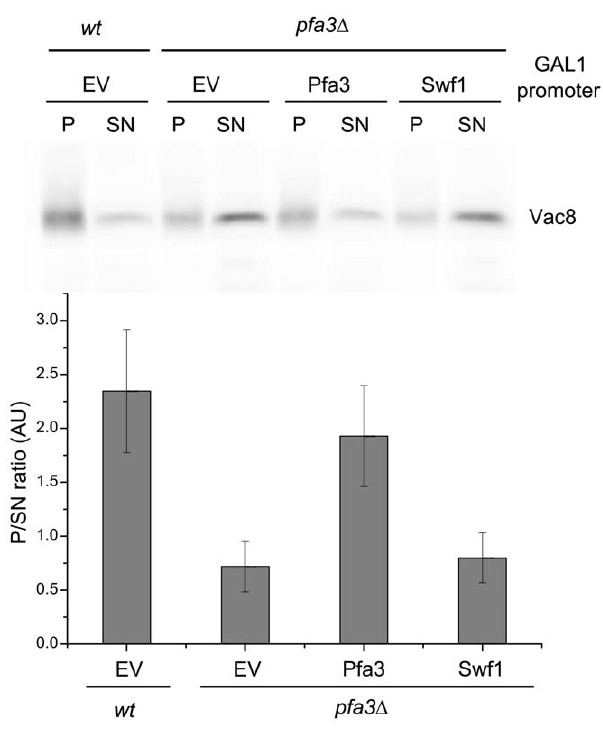
Figure 1. Swf1 does not complement a pfa3 D strain. Western blot analysis of Vac8 membrane/cytosol distribution in a wt or pfa3 D strains transformed with an empty vector (EV ) or expressing GAL1-promoter driven Pfa3-PA or Swf1-PA. The blot was developed using anti-Vac8 antibodies. The bands from four independent experiments were quantified and the ratio between the amount of Vac8 present in the the pellet corresponding to the membrane fraction (P) and the supernatant (SN) was plotted in a bar graph (lower panel).